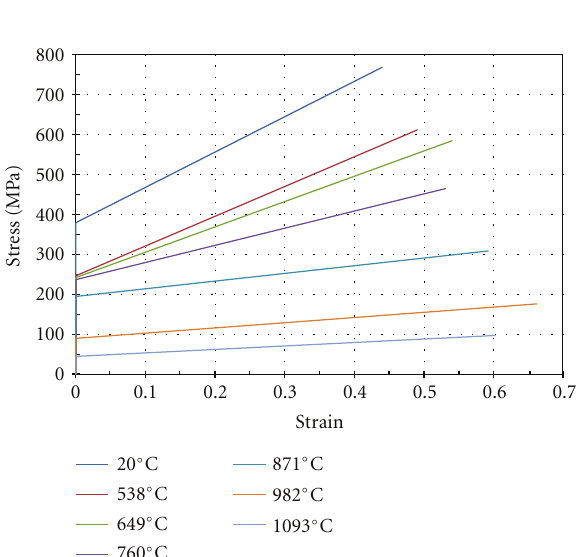
Figure 10: Bilinear stress-strain curve for an elastic-plastic analysis [10].